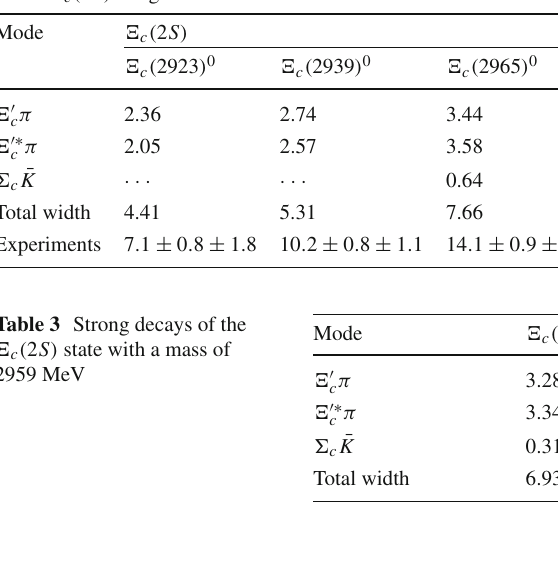
Table 2 Strong decays of the (cid:2) c ( 2923 ) 0 , (cid:2) c ( 2939 ) 0 , and (cid:2) c ( 2965 ) 0 under (cid:2) c ( 2 S ) assignments in MeV